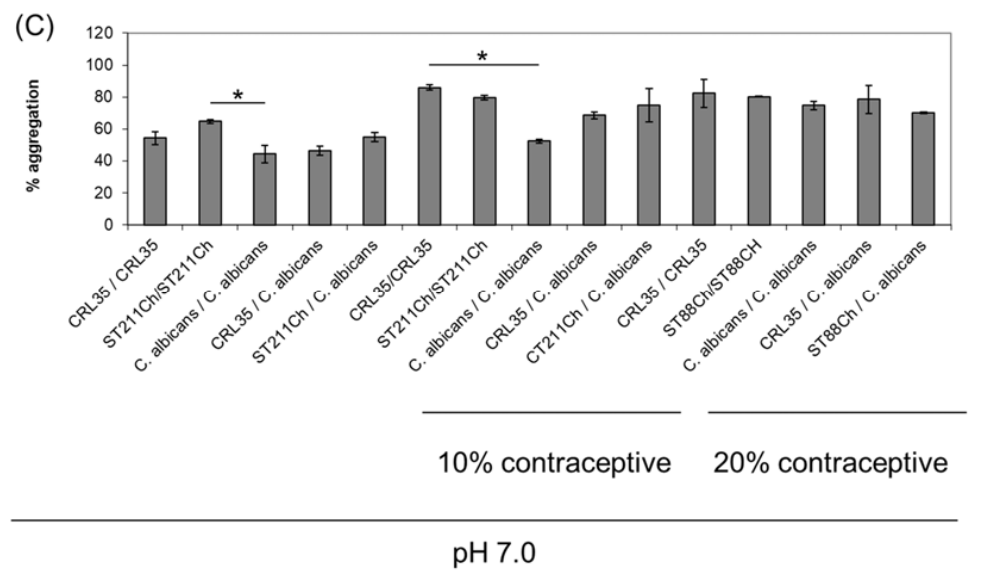
Figure 2. Aggregation properties between CRL35 ( E. mundtii CRL35), ST88Ch ( E. faecium ST88Ch) and C. albicans 1281 in presence of Nordette-28 (contraceptive) at 10% and 20% and at pH 3.0 ( A ), 5.0 ( B ) and 7.0 ( C ). Aggregation between the two BLIS-producing enterococci and C. albicans 1281 was evaluated in the presence of 10 and 20% Nordette-28 (contraceptive) and at a pH representing simplified models of the healthy and infected vaginal environments. Results are the average of three independent experiments, and SD are included. * p < 0.05. Table 3. Evaluation of the adsorption of BLIS produced by E. mundtii CRL35 and E. faecium ST88Ch to C. albicans 1281 at pH 3.0, 5.0 and 7.0 and 30 ◦ C, 37 ◦ C and 40 ◦ C (A), and in presence of 10% and 20% Nordette-28 (B). The presented results are representative of the three repetitions of the mentioned